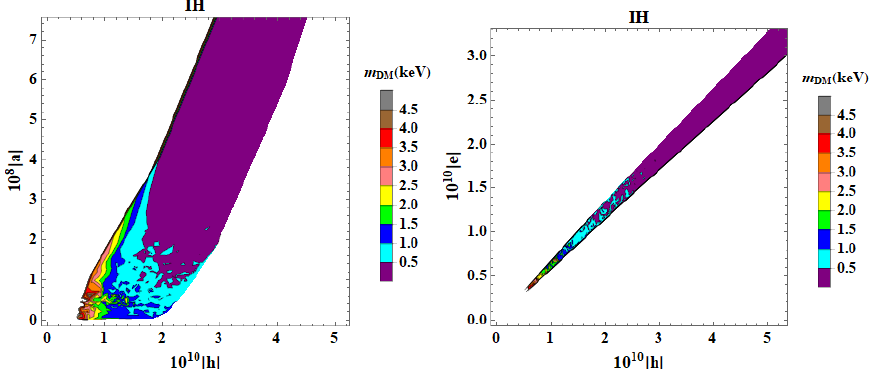
Figure 9 . Variation of di(cid:11)erent model parameters (in eV) with Dark Matter mass as a contour for inverted hierarchy The mass limit as predicted by cosmology is (0 : 4 (cid:0) 50)keV.